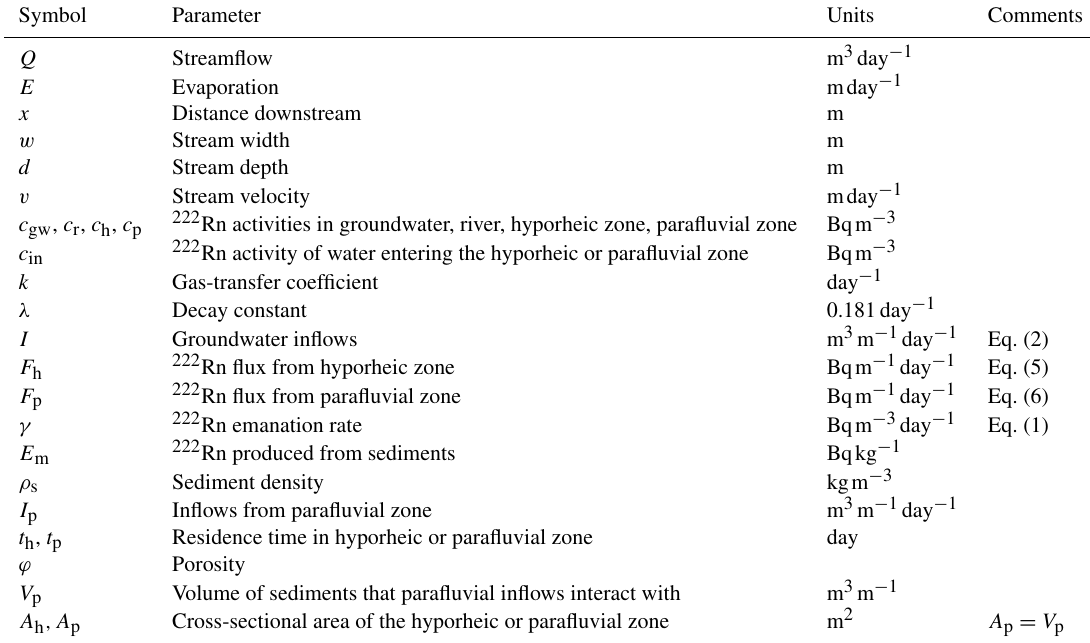
Table 1. Summary of parameters used in 222 Rn mass